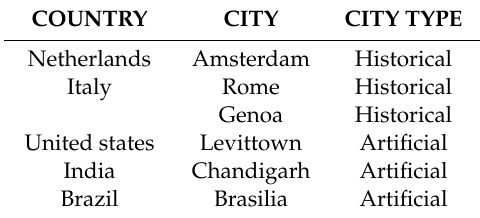
Table 1. Chosen cities and study areas within this case